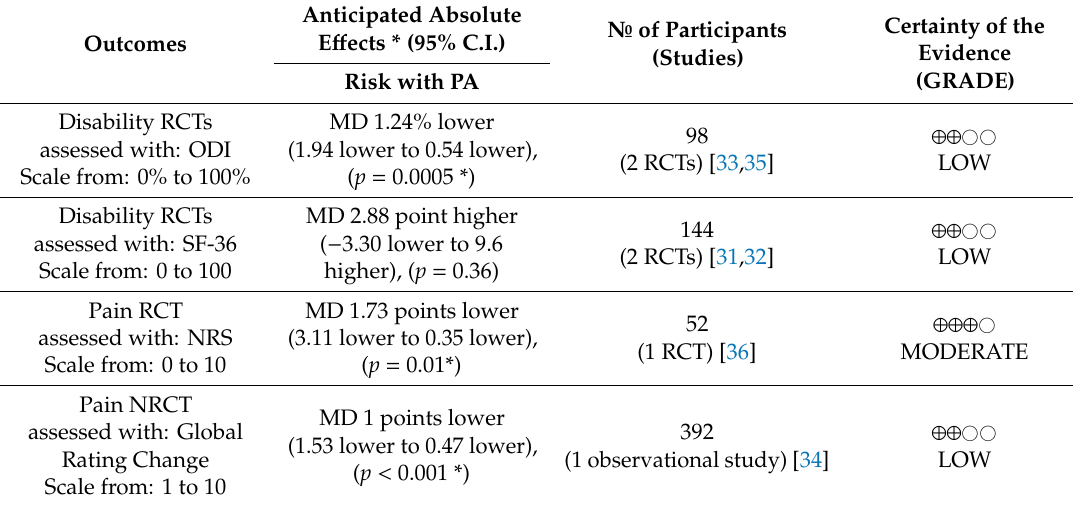
Table 4. GRADE summary of findings